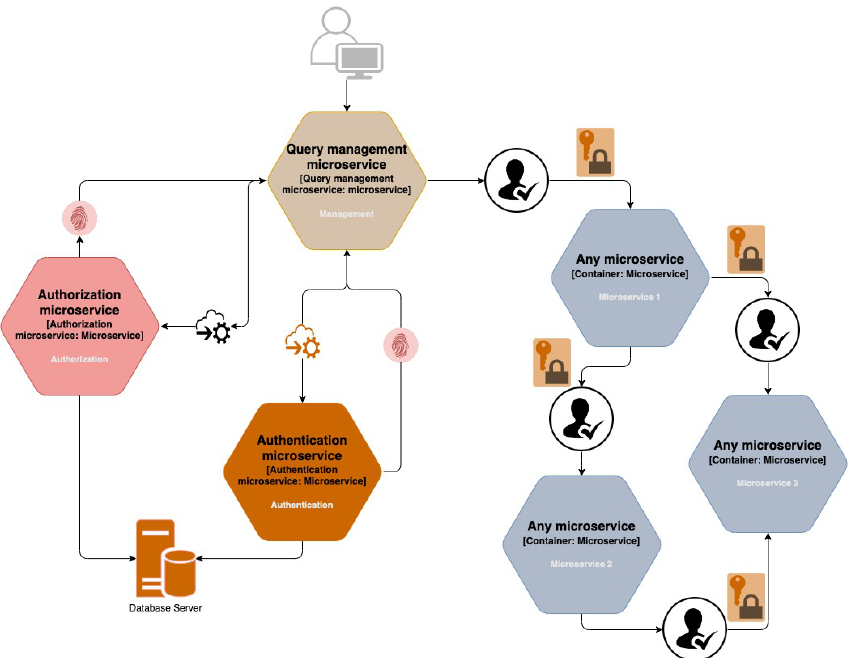
Figure 1. Concept of the JWT-driven access control in